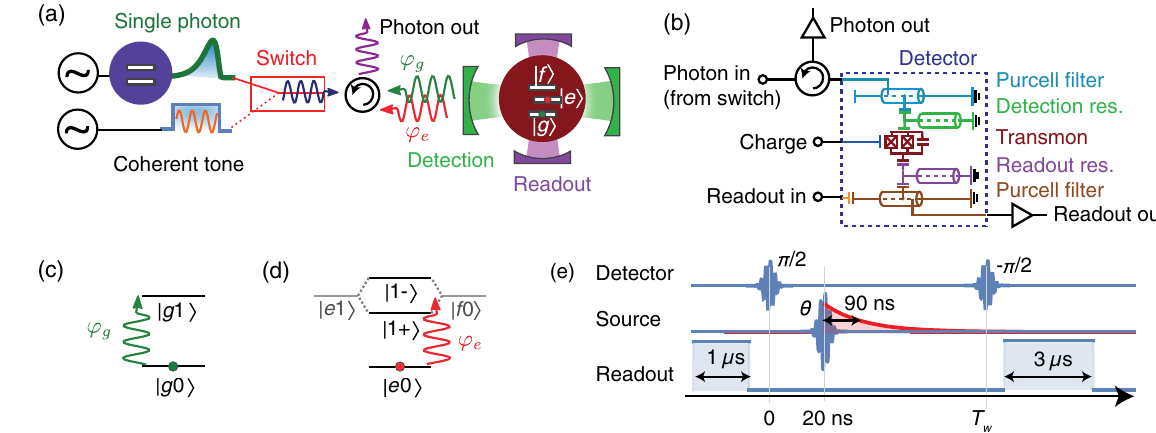
FIG. 1. Principle of quantum nondemolition single-photon detection. (a) Sketch of the setup connecting a source of single photons or a coherent source via a switch and a circulator to the input of the detector. (b) Circuit diagram of the microwave-frequency implementation of the detector chip: A transmon qubit (red) is coupled to the detection resonator (green) and its Purcell filter (light blue), as well as to a readout cavity (purple) and a second Purcell filter (brown). A charge line (dark blue) allows driving of the qubit, and a weakly coupled input port (orange) allows for transmission measurements through the readout resonator. Energy-level diagram of the atom-cavity system when the atom is either in the ground (c) or the excited state (d), contrasting the harmonic ladder of a bare cavity in (c) to the Jaynes-Cummings anharmonic ladder in (d). (e) The pulse scheme consisting of π = 2 and − π = 2 pulses applied to the detection qubit, defining the length of the detection time window T , as well as a pulse of Rabi amplitude θ applied to the source qubit. The temporal w 1 = Γ ¼ 90 ns, is sketched in red. A pulse applied mode function of the emitted photon, a decaying exponential with time constant T p ¼ to the readout resonator is used to measure the state of the detection qubit at the end of the protocol, as well as to preselect the single-shot traces to discard thermal 40 MHz. The resulting level diagram is displayed in Figs. 1(c) and 1(d). With the transmon in the ground state j g i [panel (c)], photons impinging on the detector at the resonator frequency acquire a phase φ ¼ π as they are g reflected. By contrast, with the transmon in j e i [panel (d)], photons of the same frequency are reflected without inter- acting with the cavity and thus acquire no phase ( φ ¼ 0 ). e = ð 2 π Þ ¼ 4800 MHz, with The readout resonator, at ω ro = ð 2 π Þ ¼ 17 MHz is used to per- effective linewidth κ ro form high-fidelity, dispersive single-shot readout of the qubit state [30], at a qubit-induced dispersive shift of χ = ð 2 π Þ ¼ 17 MHz. ro We connect the input of our detector to the output of a single-photon source embedded in an on-chip switch [31].